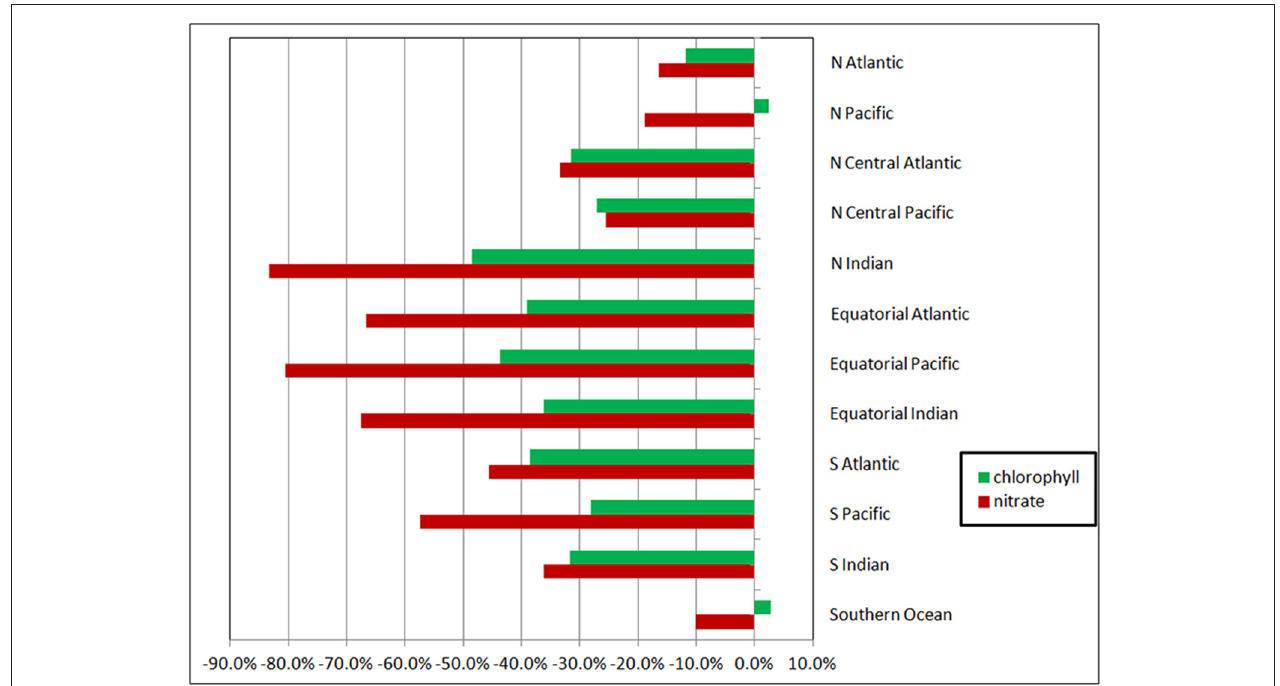
FIGURE 4 | Changes in regional nitrate and chlorophyll as a function of radiative transfer in the oceans tracking only the diffuse component. Changes are relative to the directionally-spectrally resolved model. The high latitudes are poleward of 40 ◦ latitude (i.e., the North Atlantic, North Pacific, and Southern Ocean). The tropical and sub-tropical basins are in the middle, with the tropical/sub-tropical delineation at 10 ◦ .